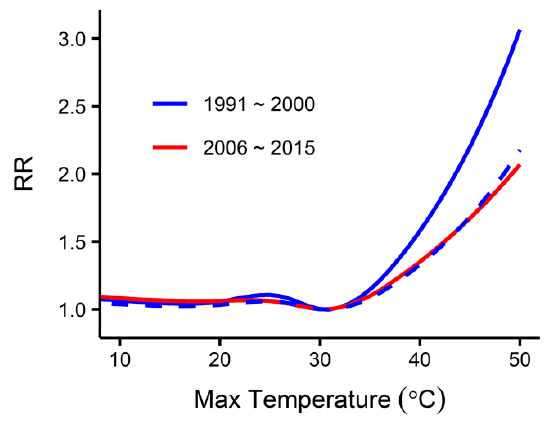
Figure 4 . The overall temperature-mortality relationships during the first (1991–2000) and the last (2006–2015) ten years of the baseline period created using DLNM. The x-axis represents the daily maximum temperature, and the y-axis represents the overall cumulative effects of the maximum temperature on mortality. The dashed curve shows the 43% slope reduced version of the relationship during 1991–2000.